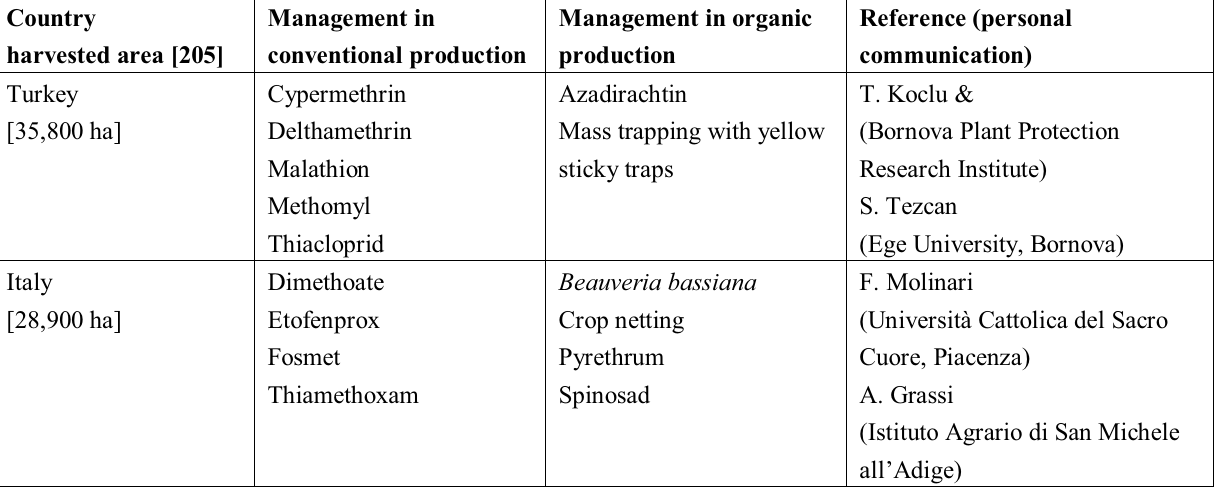
Table 1. Situation of cherry fruit fly control in different European countries in